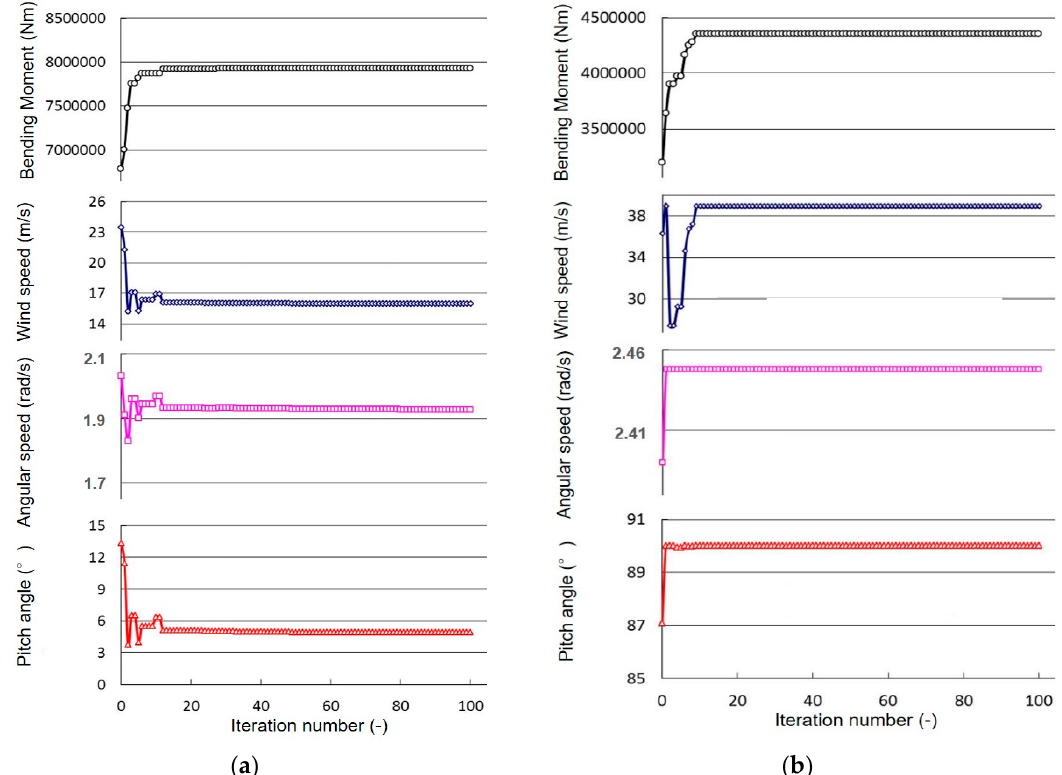
Figure 9. Iterative processes of variables: ( a ) Extreme CMF_ROOT calculation; ( b ) Extreme CMF_ROOT calculation for the 2.0 MW wind turbine blade. Table 3. Extreme bending moments and their corresponding status parameters without considering the constraint conditions about the β m